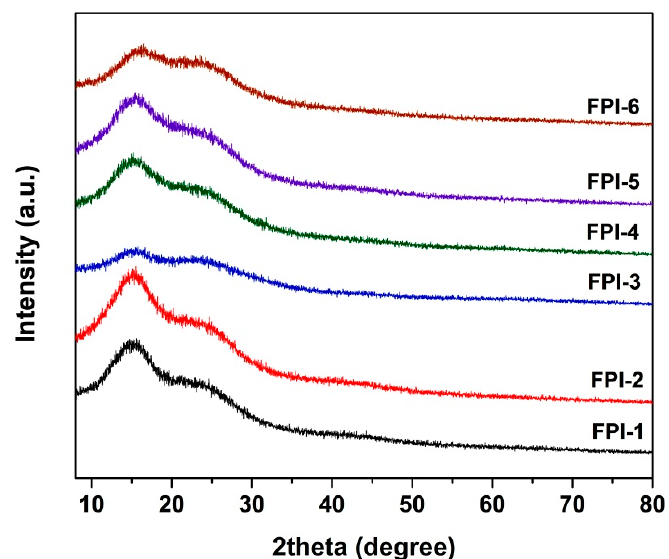
Figure 2. XRD spectra of FPI resins.